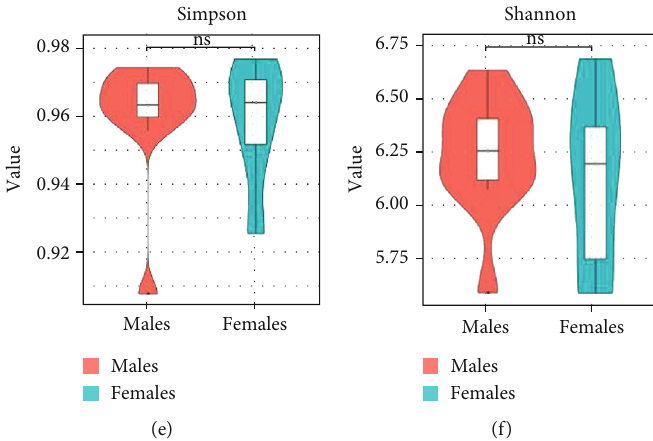
Figure 1: Sequence quality and α -diversity analysis of samples from young male and female patients with severe and advanced periodontitis. (a) Rarefaction curves based on Good ’ s coverage for all samples from males and females. The horizontal axis shows the number of operational taxonomic units (OTUs), and appropriate number of sequences is shown on the vertical axis. (b) Rank-abundance curve representative of all samples from males and females. (c – f) Violin plots comparing α -diversity indices Chao1, PD whole tree, Simpson index, and Shannon index between the two groups. ∗∗∗ P < 0 : 001 ; ∗∗ P < 0 : 01 ; ns: not signi fi primers: forward, 343 F (5 ′ -TACGGRAGGCAGCAG-3 ′ );